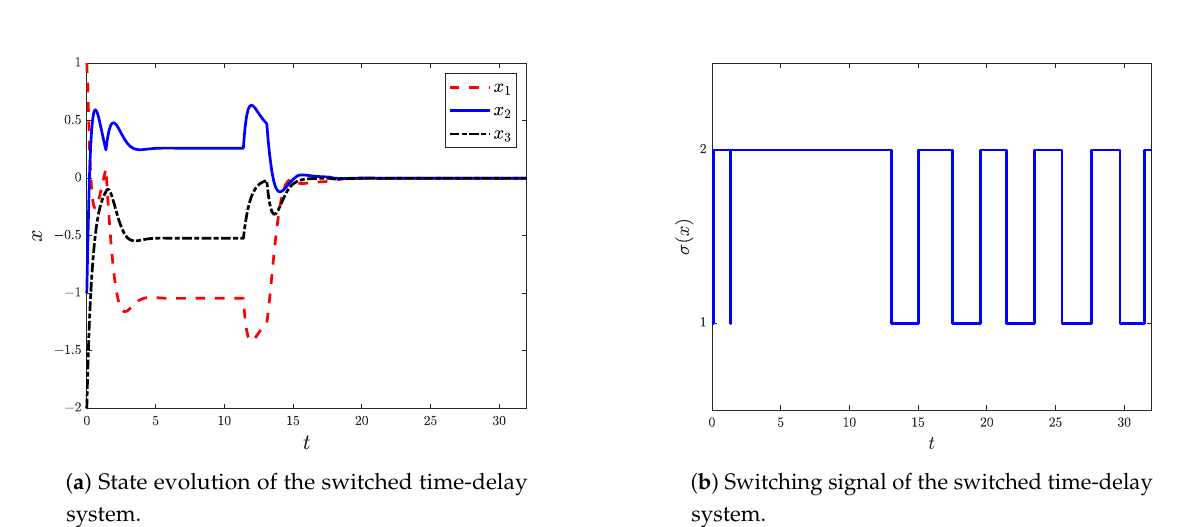
Figure 3. Example 2: evolution of the switched system under the min-projection switching strategy